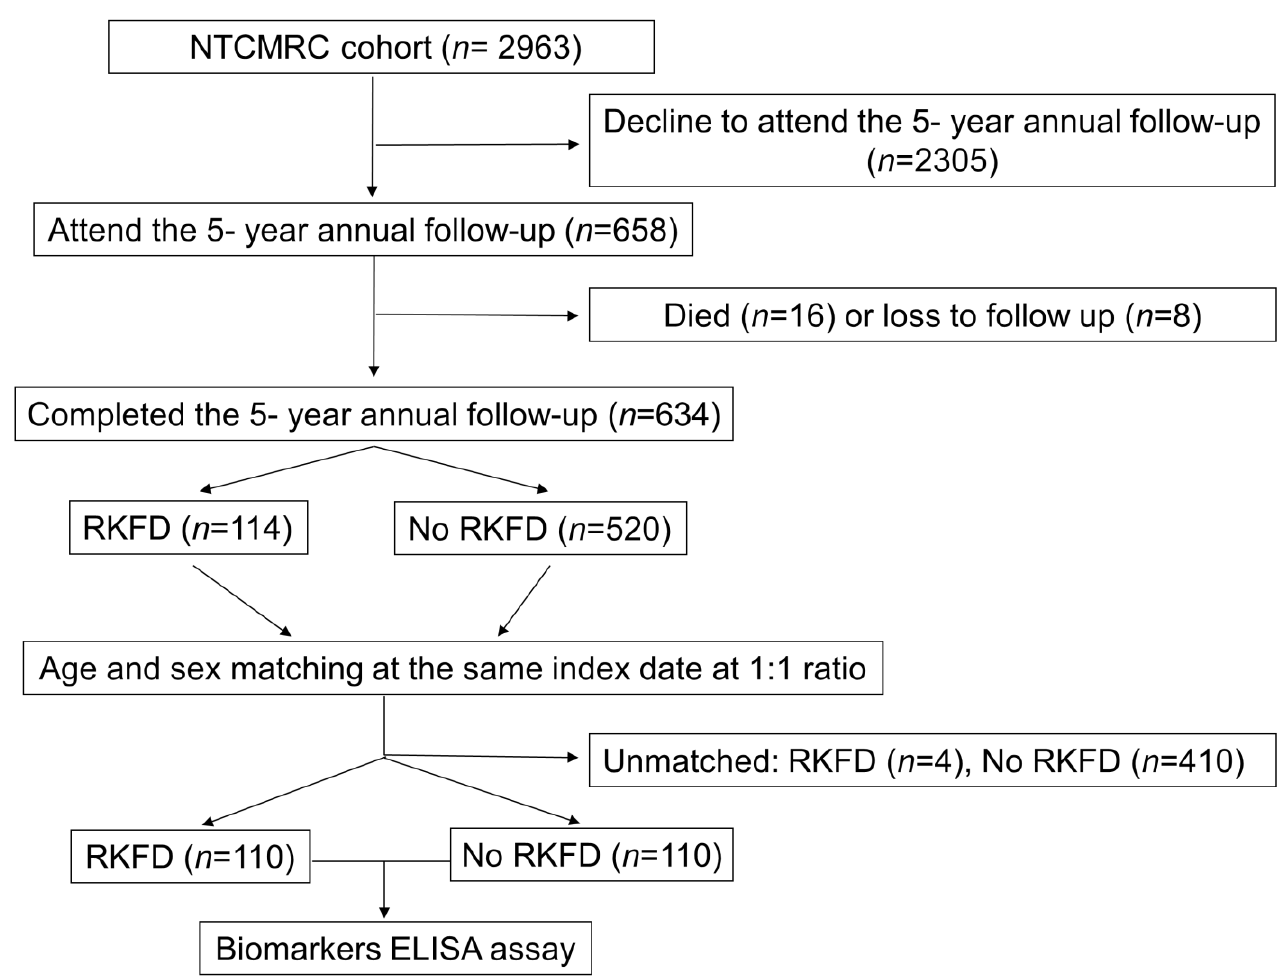
Figure 1. Flow diagram of this study. First case: 20130810, last case 20150124. Abbreviations: ELISA, enzyme-linked immunosorbent assay; NTCMRC, Northeastern Taiwan Community Medicine Research Cohort; RKFD, rapid kidney function decline.